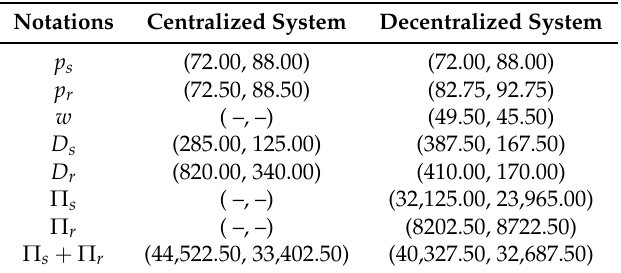
Table 2. The total profits in centralized and decentralized